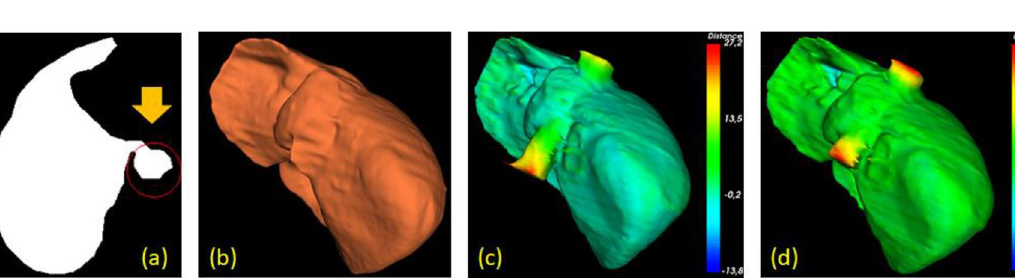
Figure 13. A case of a IVC being included in the segmented liver ( a ). The correct 3D ground truth is shown in ( b ). The reconstructed liver surfaces before ( c ) and after ( d ) manual IVC removal indicates significantly lower distance